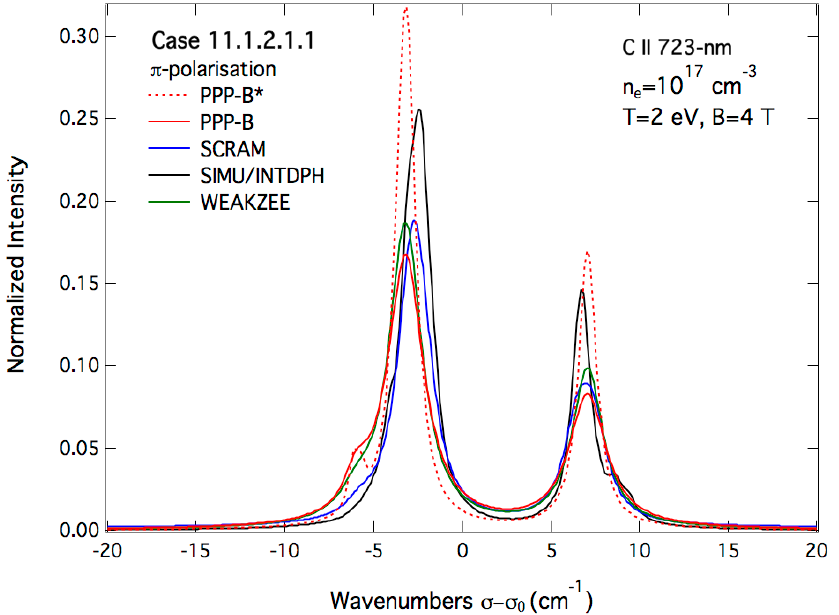
Figure 6. Comparison of the Stark–Zeeman π -component of the C II 723-nm line as computed by the different line-shape codes for the same conditions as in Figure